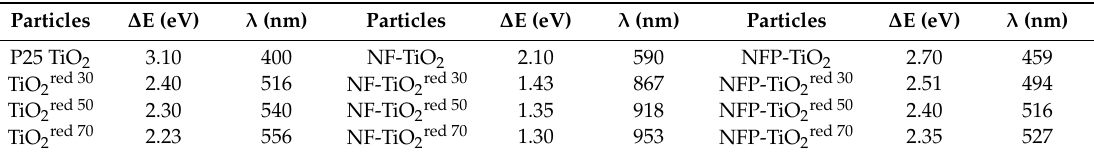
Table 2. Band gap of NaBH 4 treated P25 TiO 2 , NF-TiO 2 , and NFP-TiO 2 series and their corresponding photoexcited absorption wavelength.